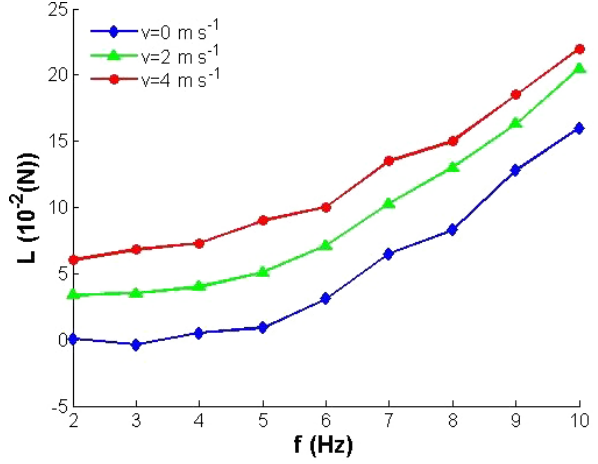
Figure 10. The average lift force versus flapping frequency for dif- ferent wind